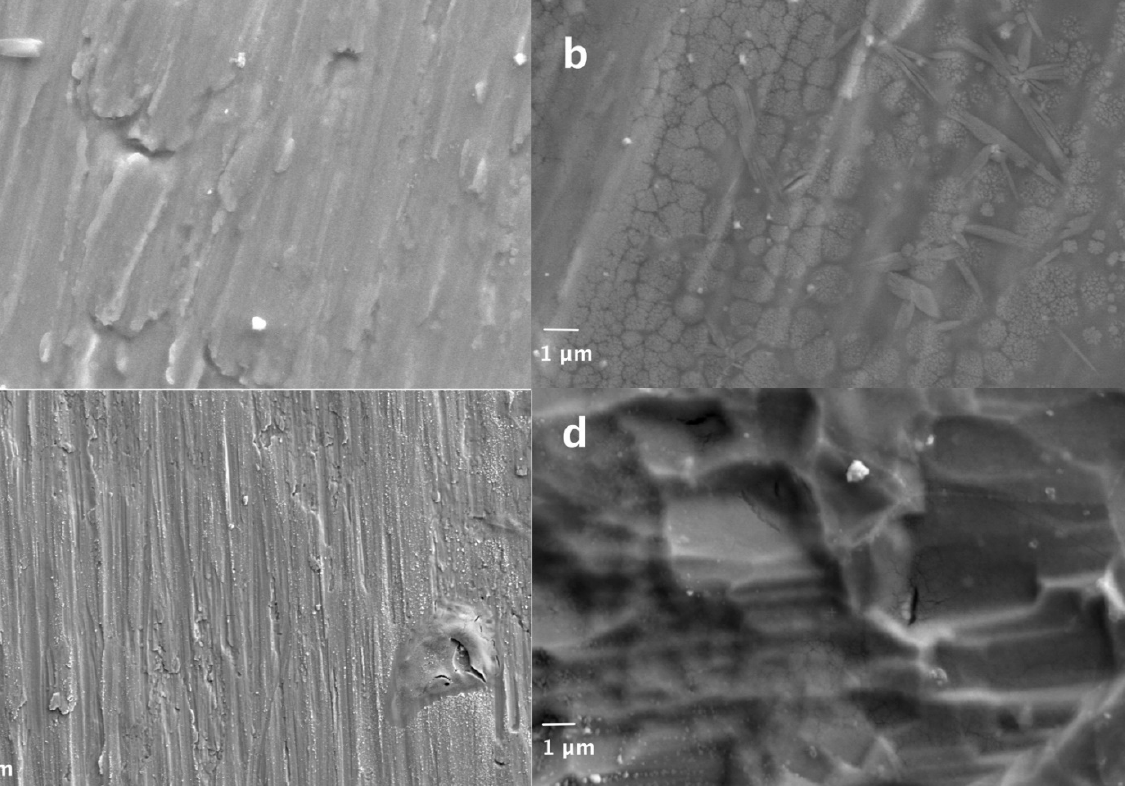
Figure 1. SEM images of: ( a ) electrode E-01 (precursors: RuCl 3 and Mn(acac) 3 ; smooth); ( b ) electrode E-02 (precursors: Ru(acac) 3 and Mn(acac) 3 ; smooth); ( c ) electrode E-04 (precursors: Ru(acac) 3 and Mn(NO 3 ) 2 ; smooth); ( d ) electrode E-03 (precursors: Ru(acac) 3 and Mn(acac) 3 ; etched).